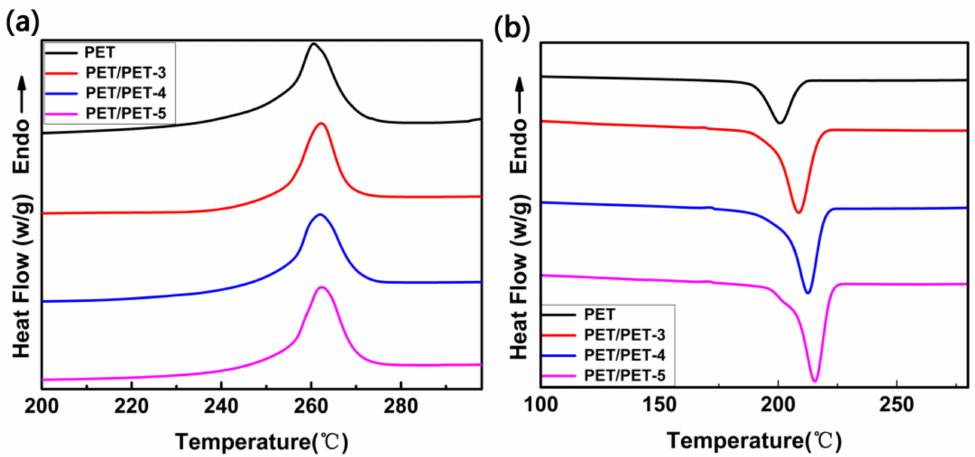
Figure 7. The heating curve ( a ) and the cooling curve ( b ) at the rate of 10 ◦ C · min –1